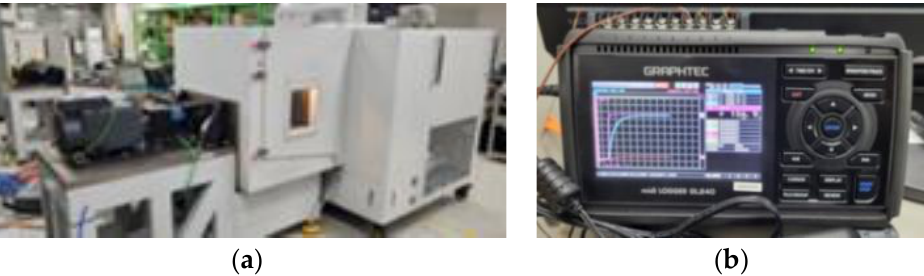
Figure 24. Experiment and measurement equipment for analyzing the change of back EMF due to temperature: ( a ) thermo-humidity chamber combined dynamo test bench; ( b ) temperature meas- urement using a temperature data logger.